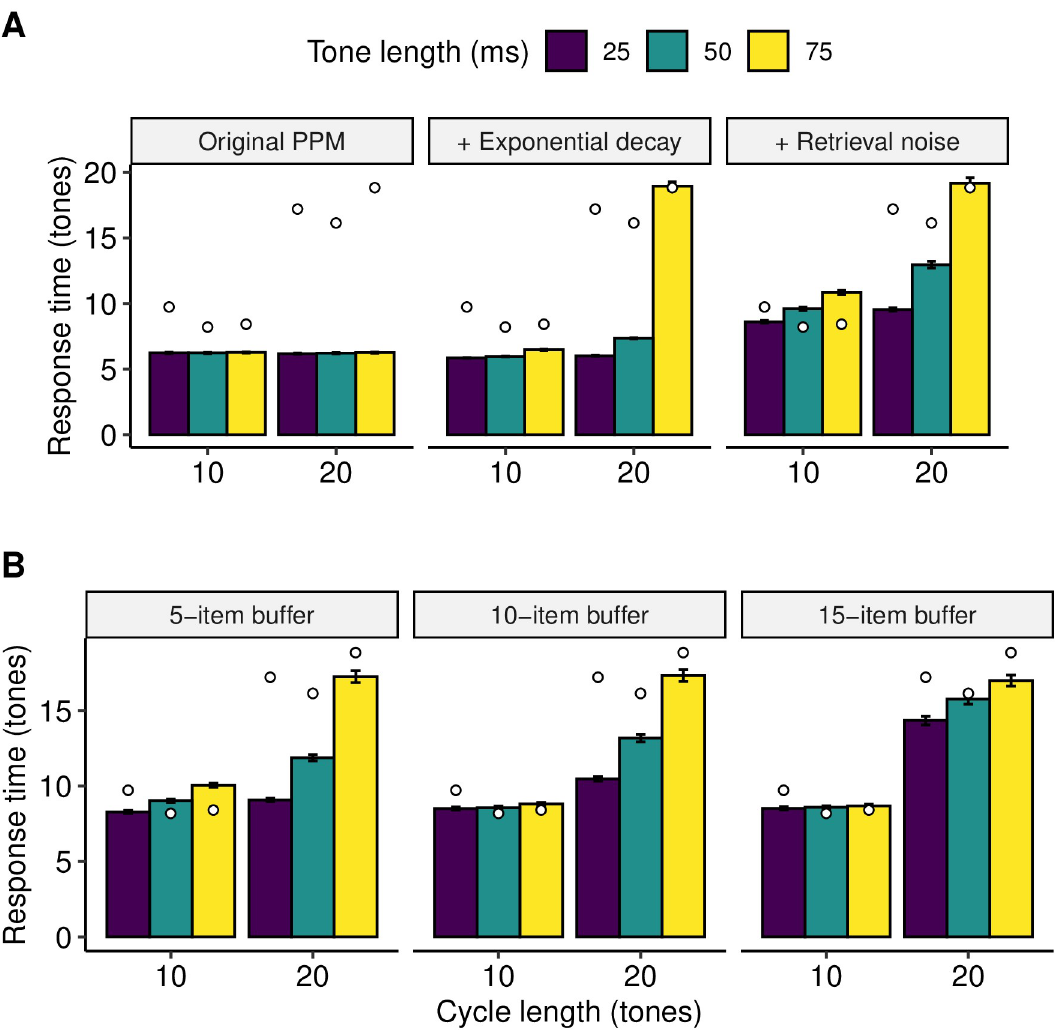
Fig 8. Modeling participant data in Experiment 3. Participant data (mean response times) are plotted as white circles, whereas different model configurations (mean simulated response times) are plotted as solid bars. Error bars denote 95% confidence intervals computed using the central limit theorem. A) Progressively adding exponential weight decay and retrieval noise to the original PPM model. B) Progressively adding longer buffers to the PPM-Decay